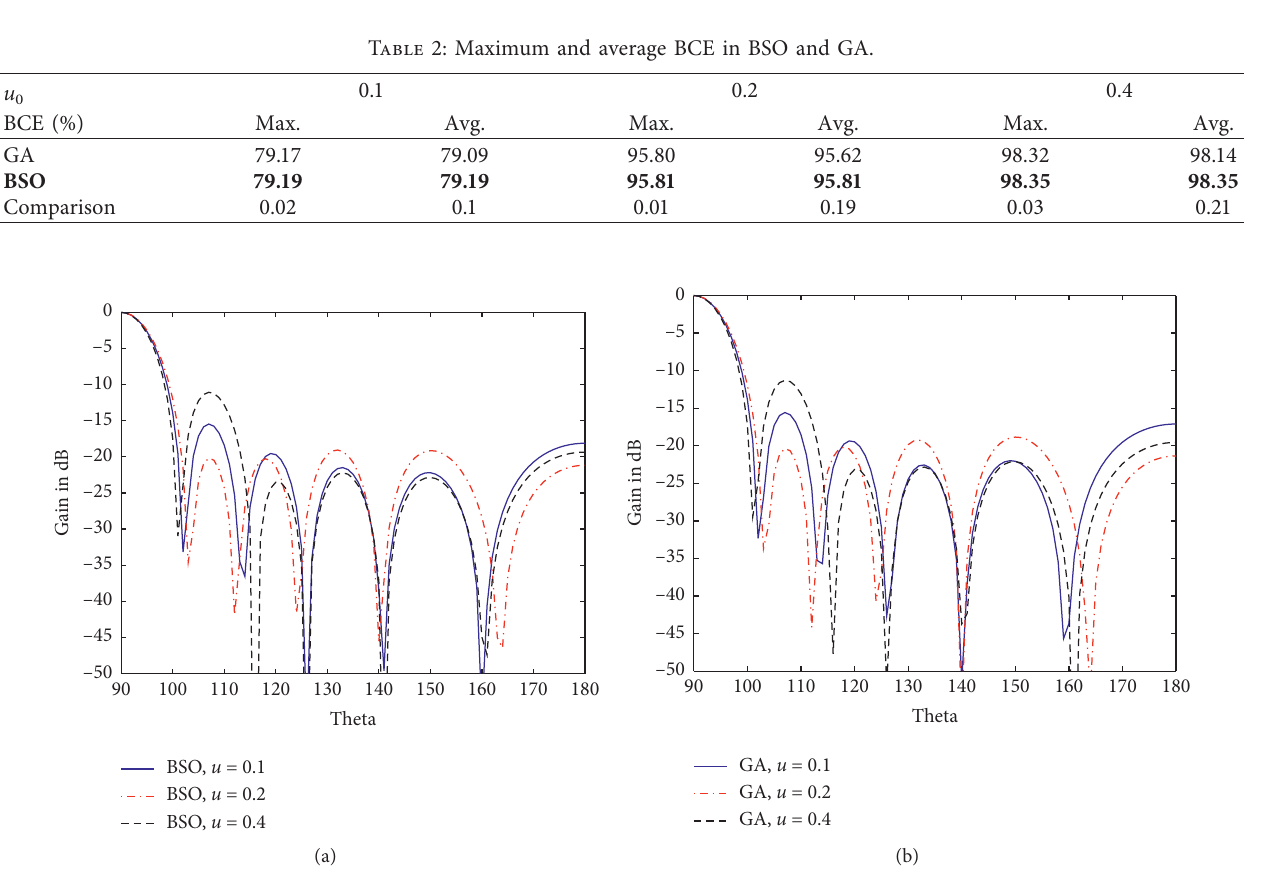
Figure 3: Different u 0 examples: best-normalized power pattern found by BSO (a) and GA (b) (in 20 times